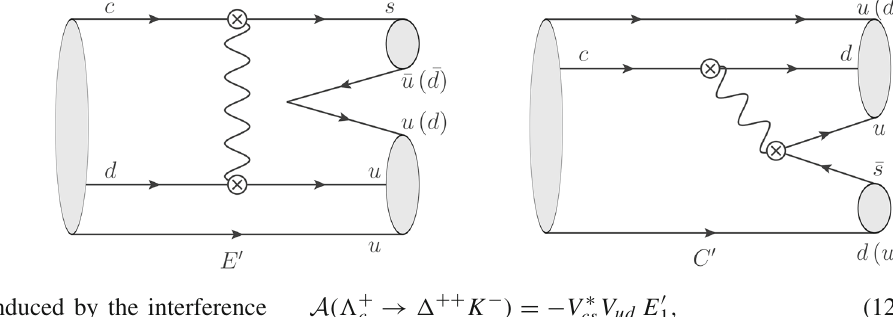
Fig. 1 Topological